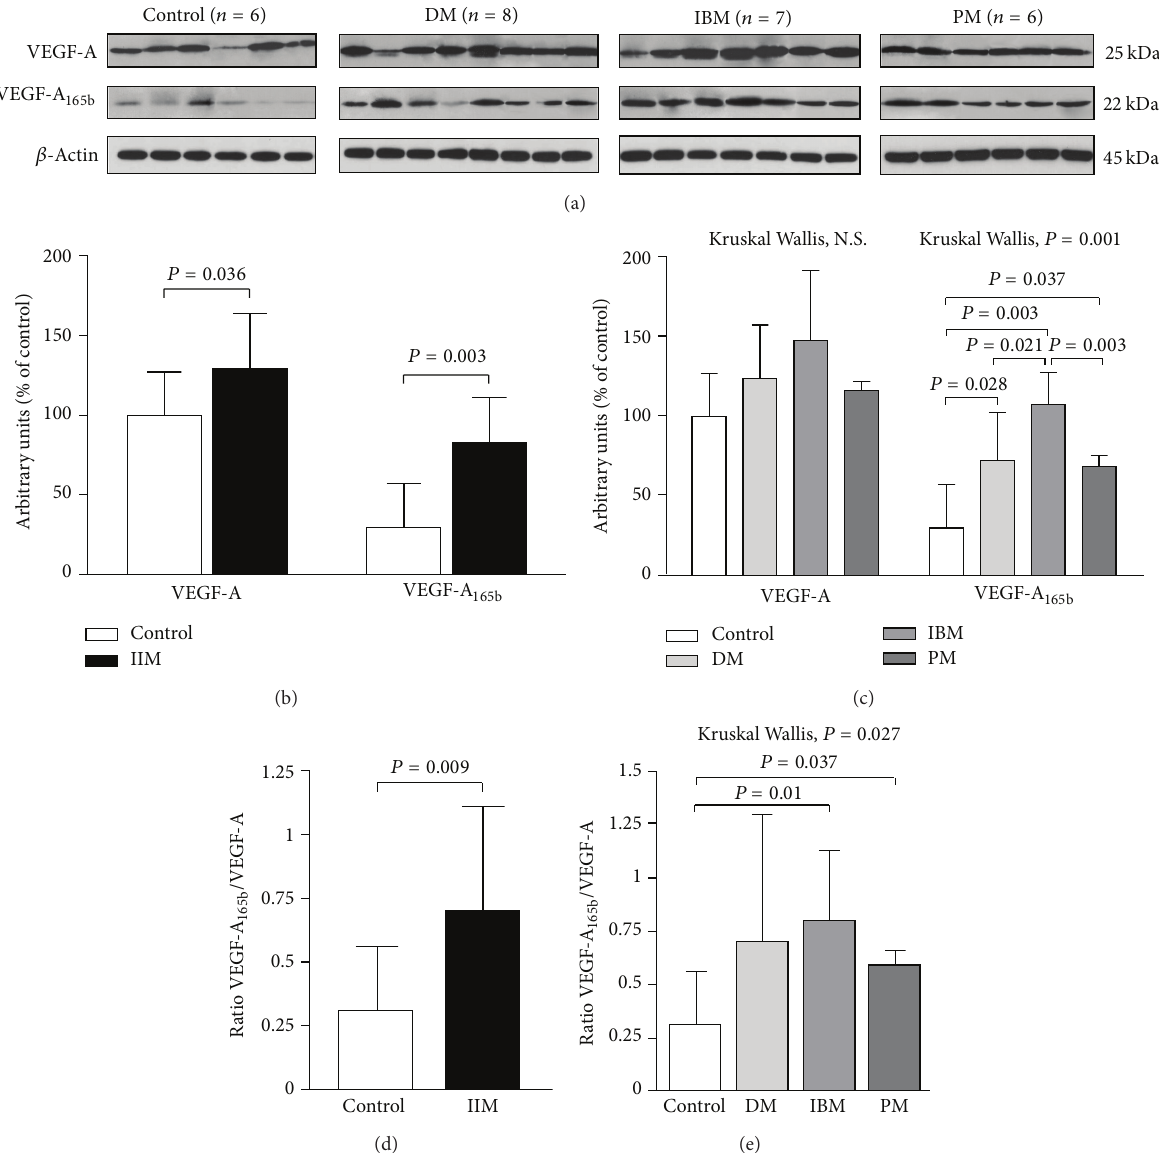
Figure 1: Increase of VEGF-A and VEGF-A 165 western blots (a). Densitometric quantification of the VEGF-A and VEGF-A 165 in IIM (b) and in DM, IBM, and PM subsets (c). VEGF-A 165 arbitrary units from five independent experiments. Histograms represent mean values ± SD. All the statistical significant differences were